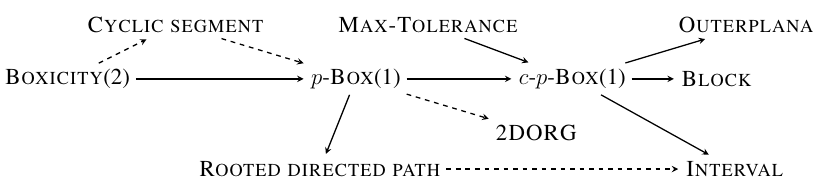
Fig. 8: Relation between the graph classes in the document. Arrows point from the superclass to the subclass. Dotted lines represent previous results and solid lines represent results proved in this